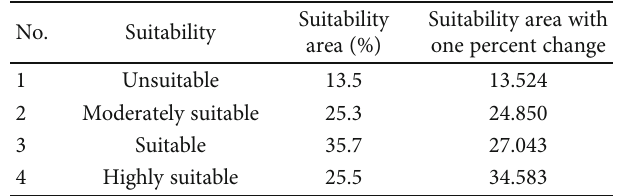
Figure 11: Suitability map of solar PV. Table 16: Suitability area percentage of sensitivity analysis for one percent change in solar